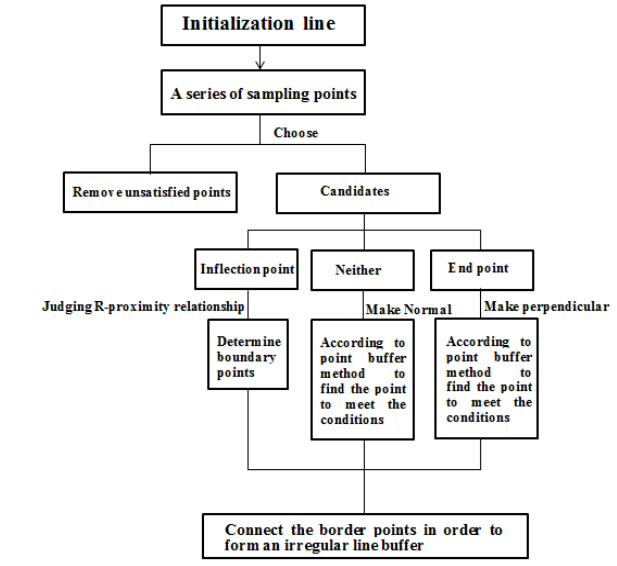
Figure 3. Irregular line buffer implementation process